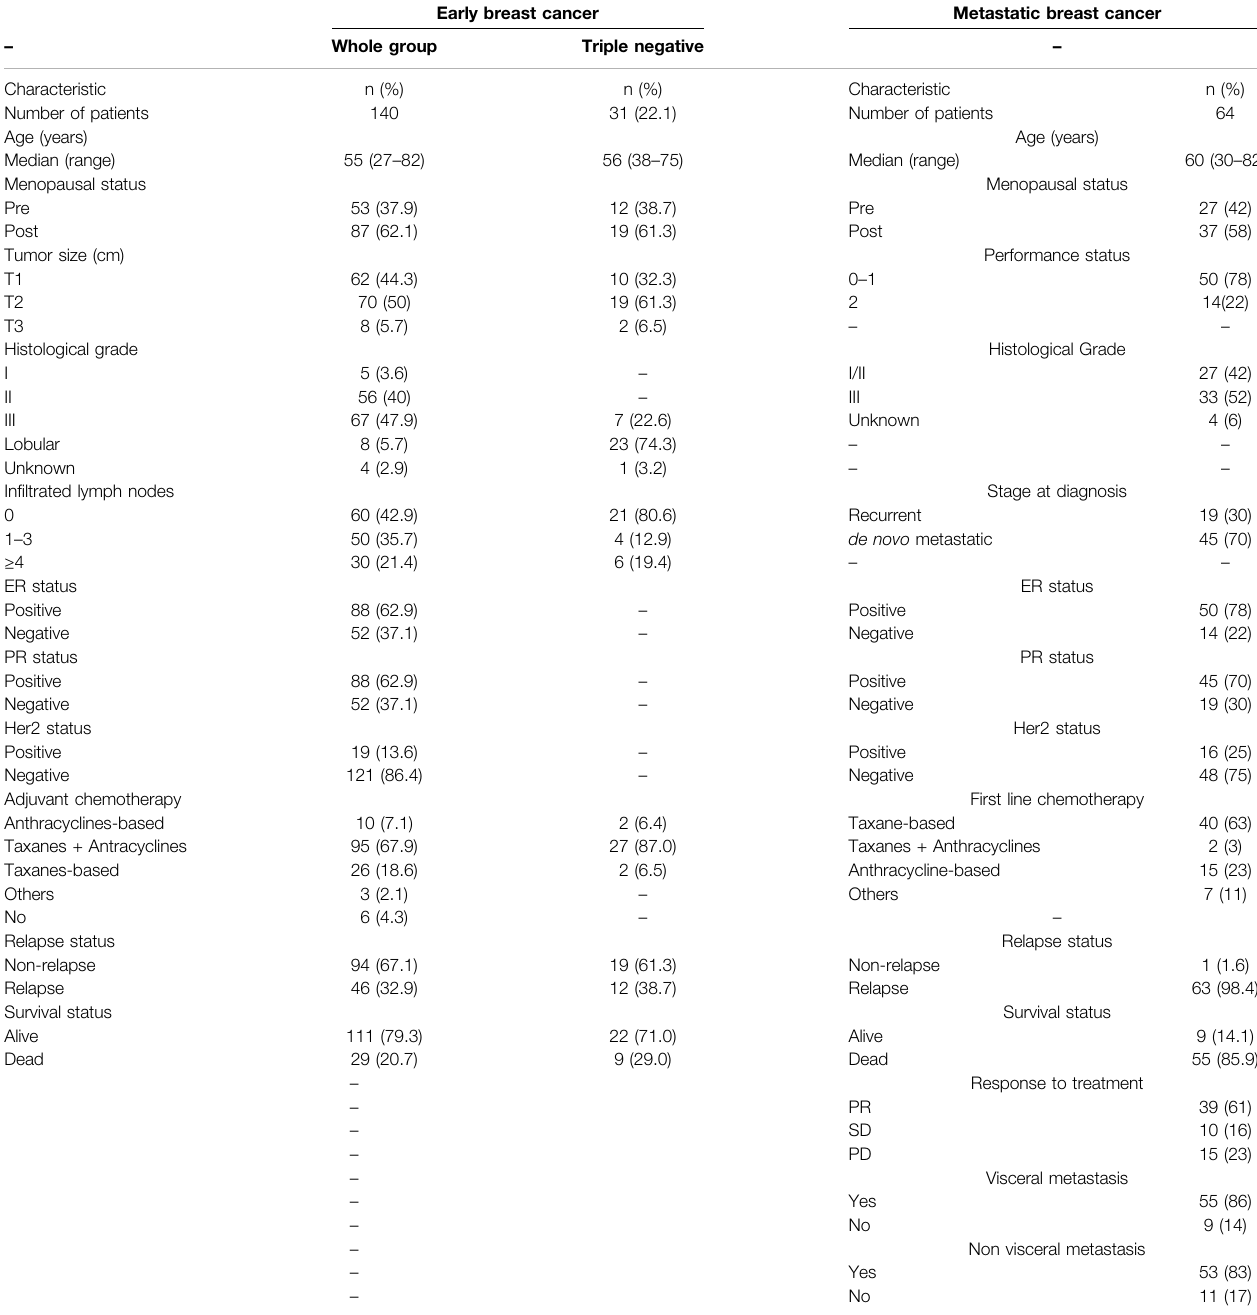
TABLE 1 | Clinical and disease characteristics of breast cancer